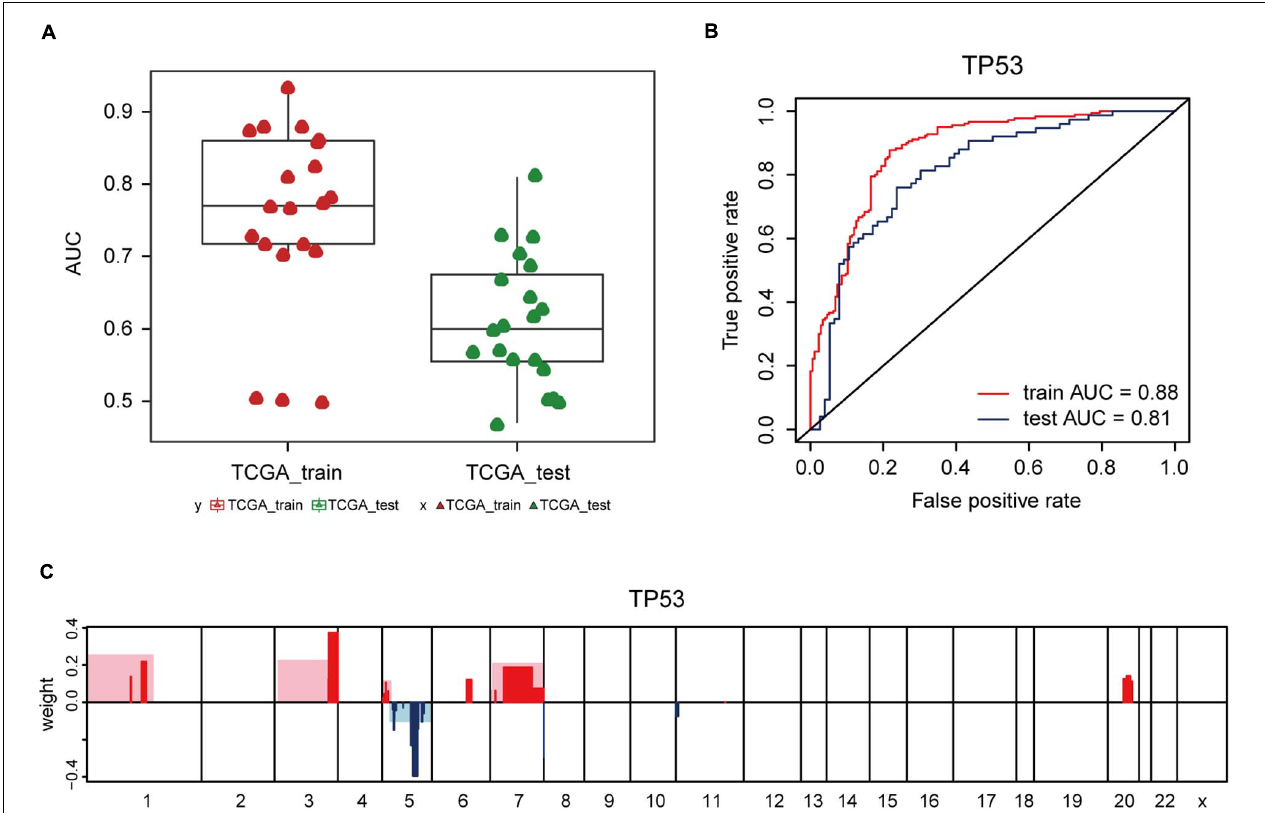
FIGURE 4 | CNV-based genetic mutation prediction. (A) AUC distributions of CNV-based predictions for top 20 genes with the highest mutation frequencies selected from TCGA lung adenocarcinoma mutation data. (B) ROC curves and corresponding AUC values of TP53 mutation status in the TCGA training and test sets. (C) Elastic Net-selected CNV segments and whole chromosomal arms and their coefficients selected for prediction models for TP53 mutation.